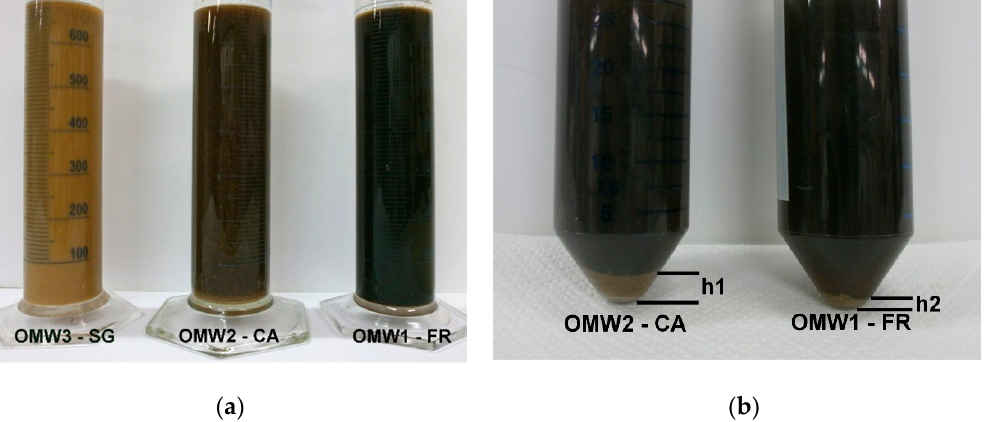
Figure 2. ( a ) Images of OMWs after settling and bag filtration. ( b ) Images of OMWs after centrifugation (h = TSS volume). Table 4. Physicochemical properties of OMWs fed to the microfiltration plant.